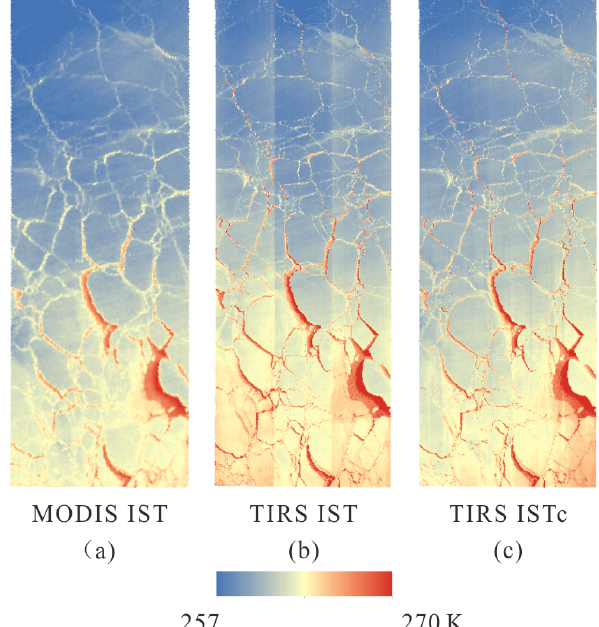
Figure 5. Ice surface temperature (IST) maps from MODIS and Landsat-8 Thermal Infrared Sensor (TIRS) using split-window al- gorithms: (a) IST map from MODIS, (b) IST map from Landsat-8 TIRS, and (c) corrected IST map from